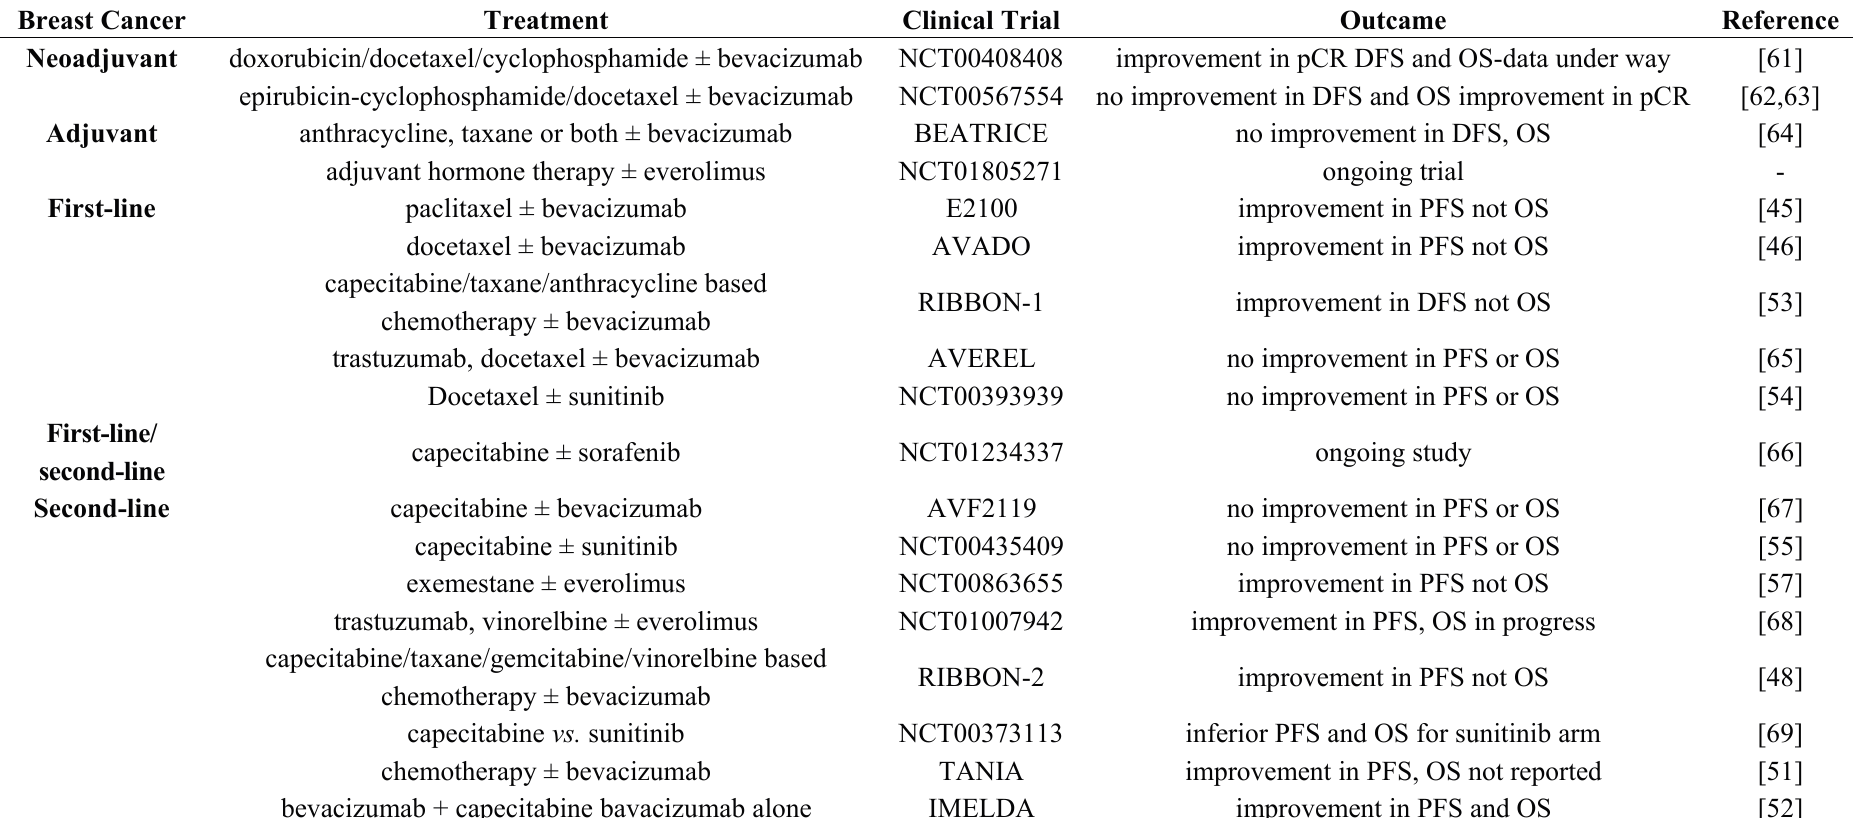
Table 1. Antiangiogenic drugs used in breast cancer treatment-clinical